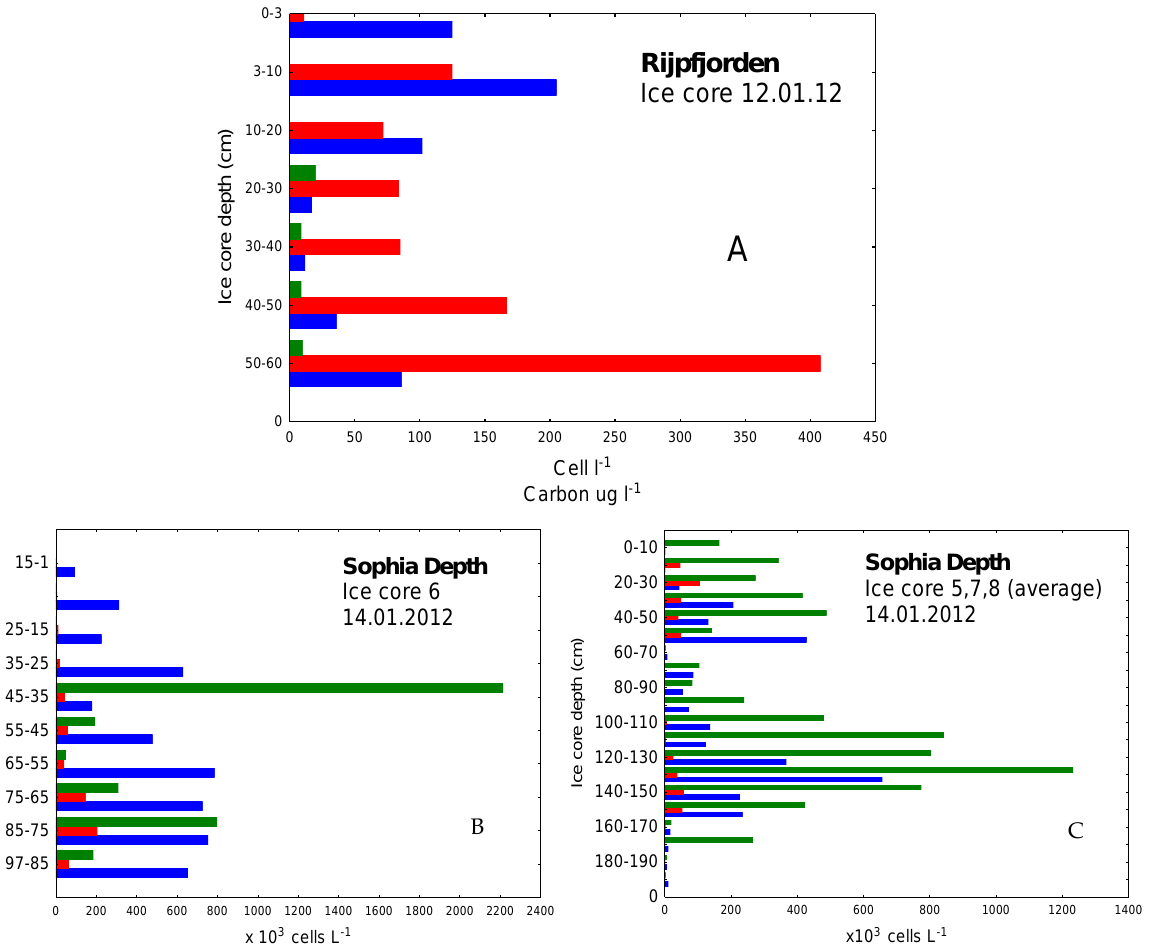
Figure 4. Vertical distribution of diatoms, spores and cysts of the dinoflagellate Polarella glacialis (cells L −1 ) in ice cores from Rijpfjorden ( A ) and the northern Barents Sea pack (Sophia Depth, B , C ) ice in January. Blue bars = diatoms, red bars = diatom spores, green bars = Polarella cysts. Table 2. Dominating and common diatoms related to time of the year and ice thickness in the Barents Sea pack ice. Bold denotes dominating species. Area Time of Year Dominating and Common